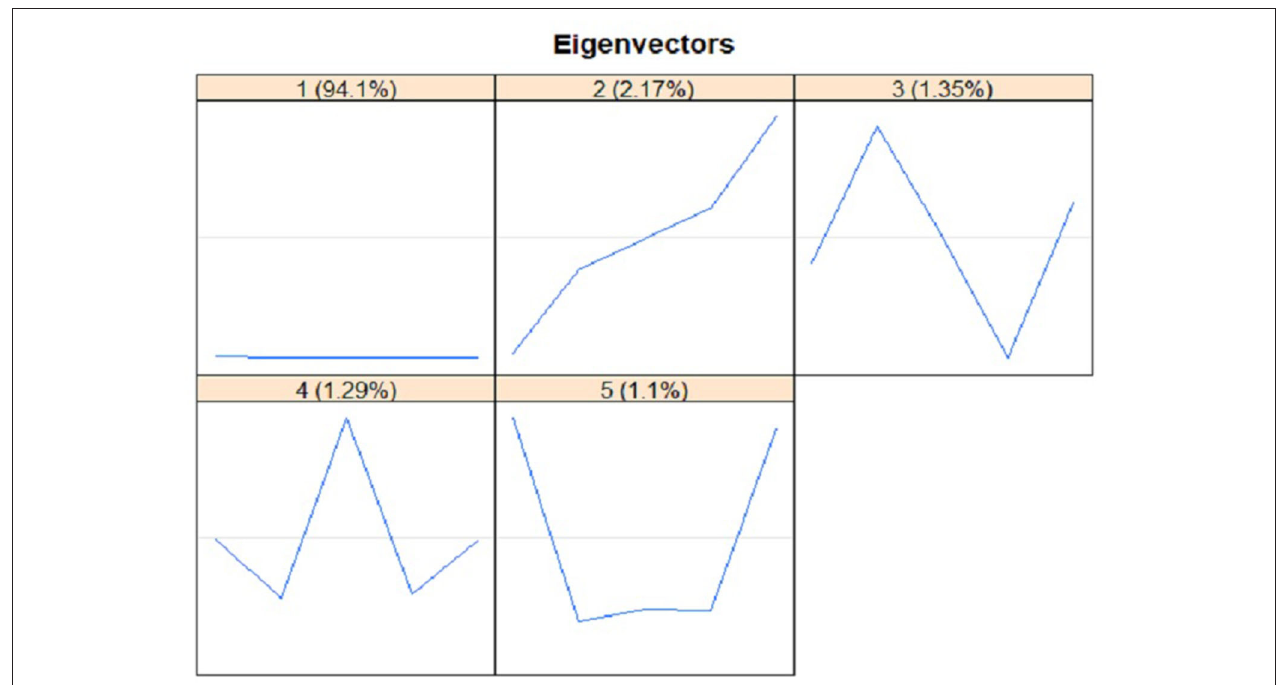
FIGURE 6 | Eigenvectors Plot using Singular Spectrum Analysis.